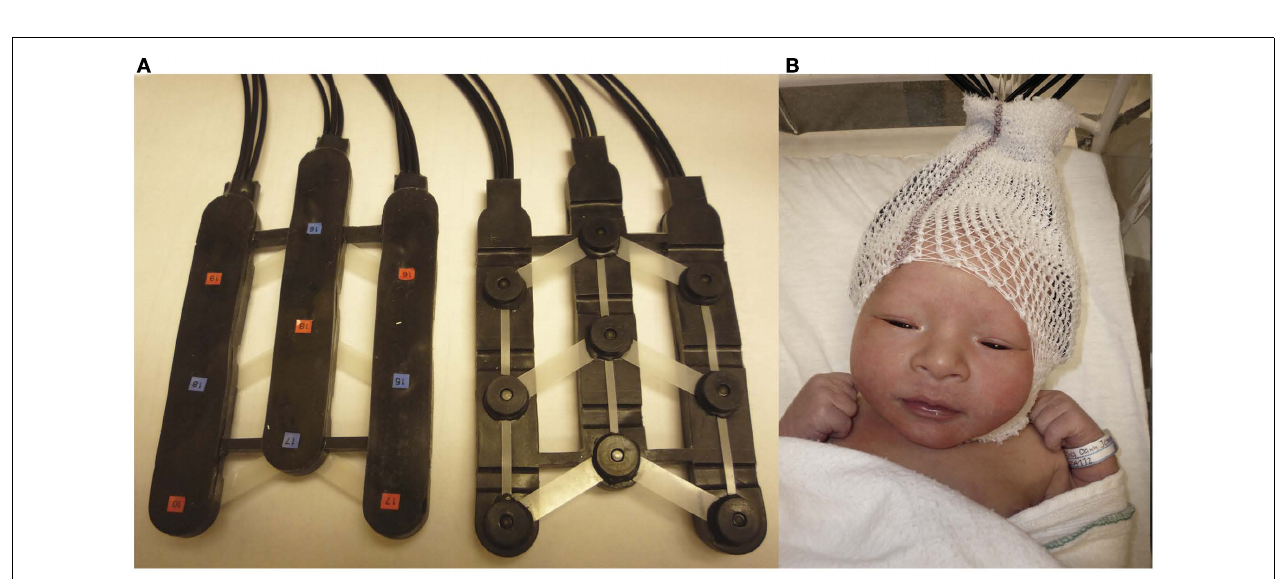
FIGURE 1 |The block design used in the current study. Each infant was exposed to all four language conditions (FW, BW English; FW, BWTagalog).Within each language condition, infants heard seven language blocks of five sentences. Each sentence was 3–4s in length.